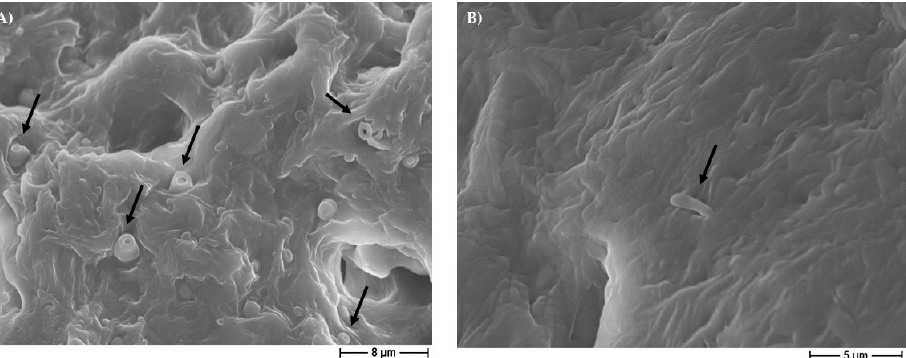
Figure 14. Representative FESEM micrographs of S. aureus ( A ) morphological alteration (black arrows) on 30% cinnamon oil PCL-based scaffolds (3000 × magnification), and of E.coli ( B ) morphological enlargement (black arrow) on 30% eugenol PCL-based scaffolds, obtained by using NaCl salt as a template (5000 × magnification).